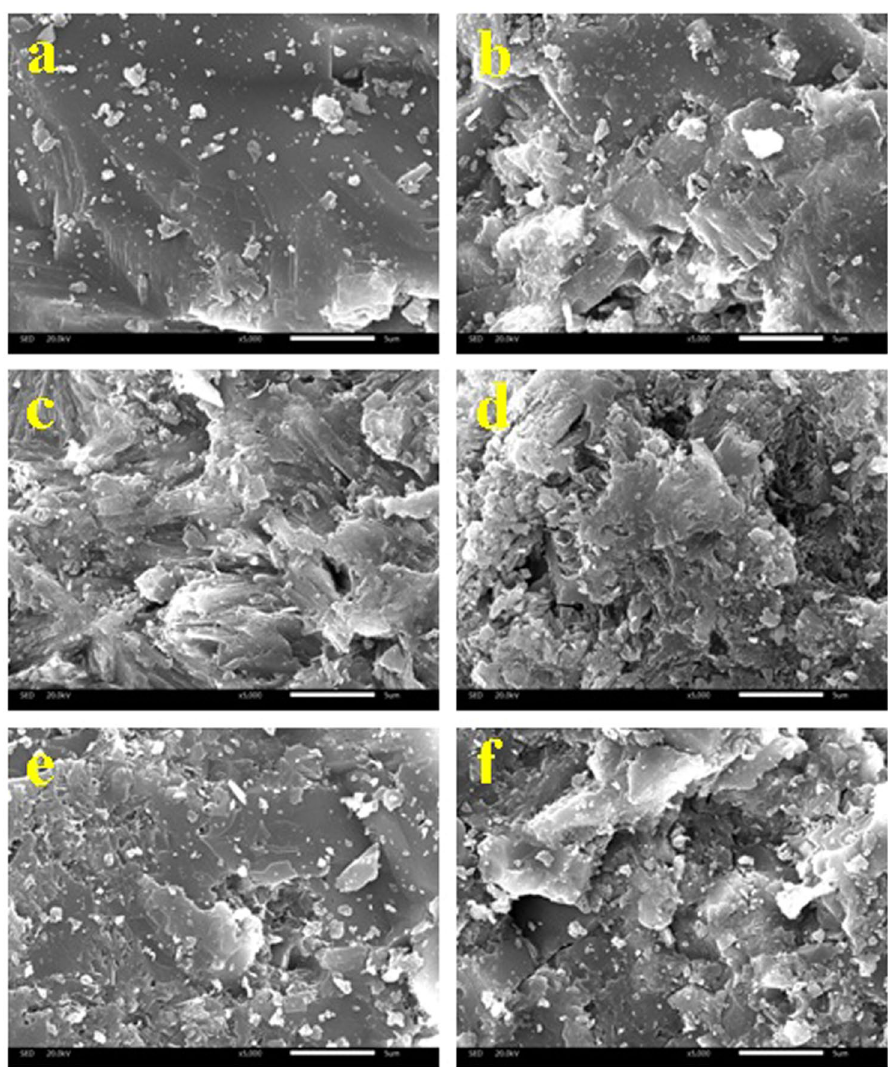
Figure 4. SEM micrographs of ( a ) RMF ( b ) MMF-H2.5 ( c ) MMF-OH3.0 ( d ) MMF-La5.0 ( e ) CMMF-400 and ( f )